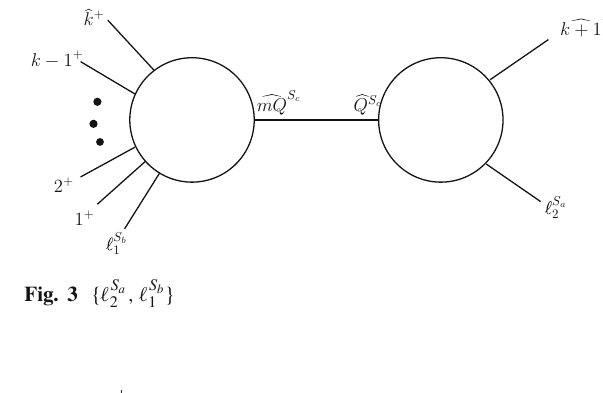
Fig. 3 { (cid:2) S a